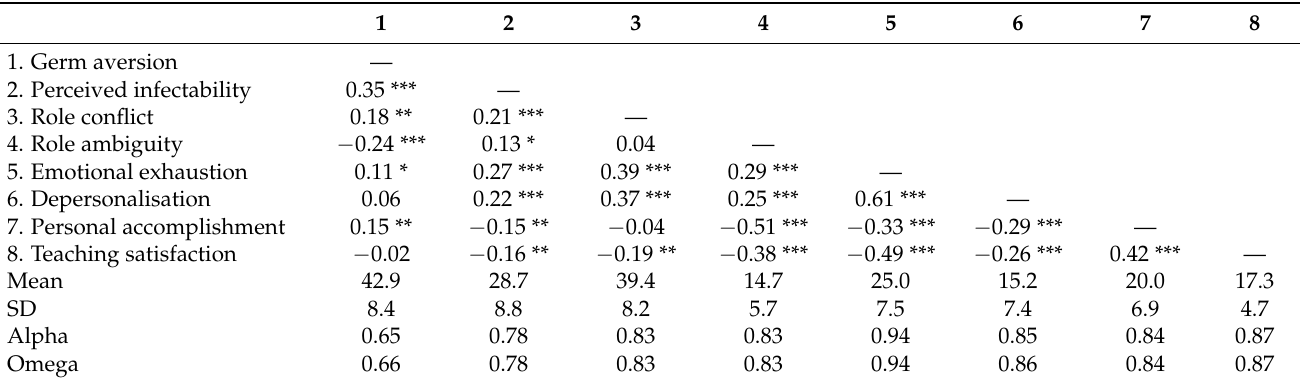
Table 1. Descriptive statistics, reliabilities, and intercorrelations between